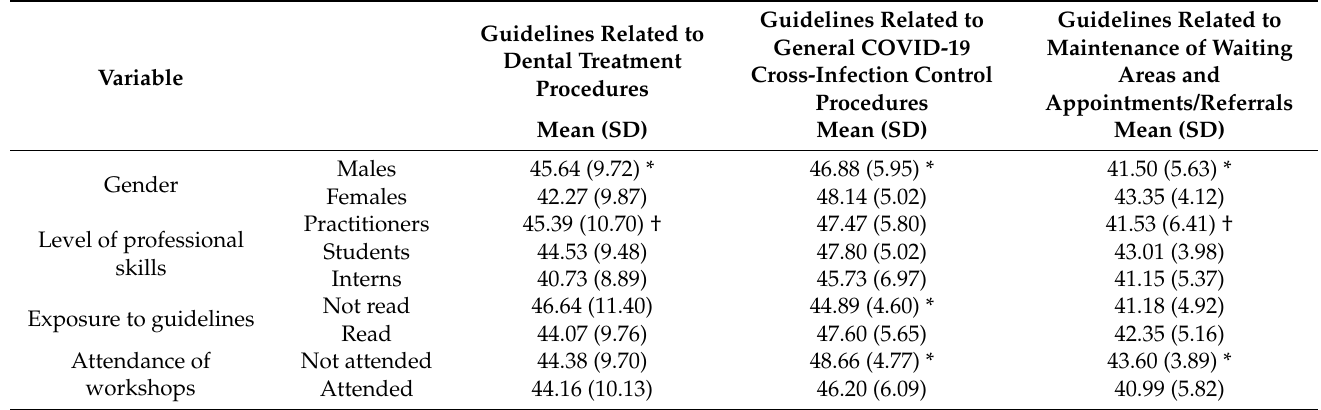
Table 4. Overall and factor scores concerning gender, level of professional skills, exposure to guide- lines and